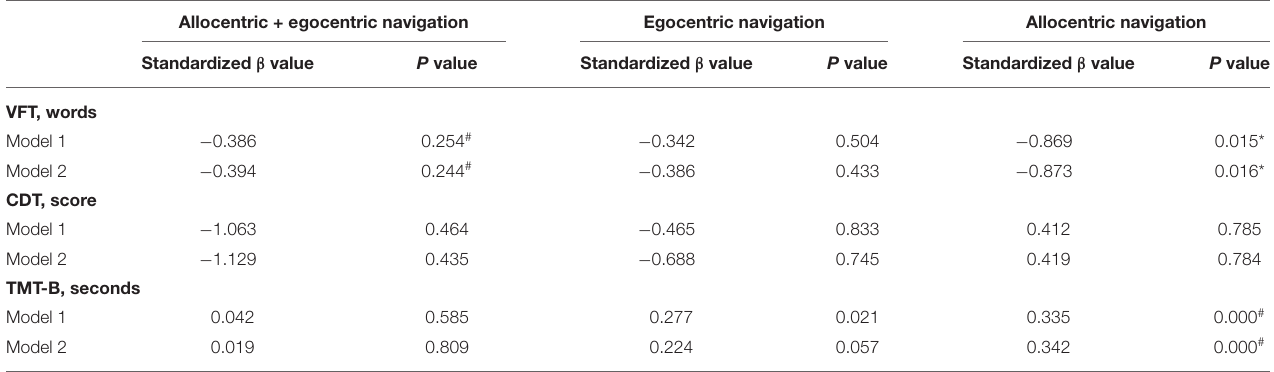
TABLE 2 | Association between the index of spatial navigation performance and neuropsychological assessment data in aged SVD patients. Allocentric + egocentric